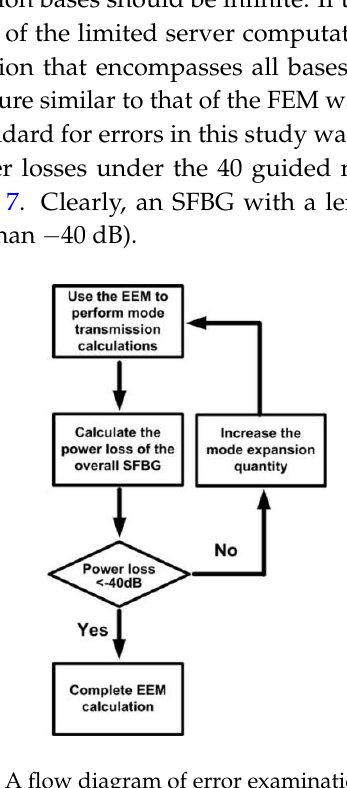
Figure 6. A flow diagram of error examination for EEM.